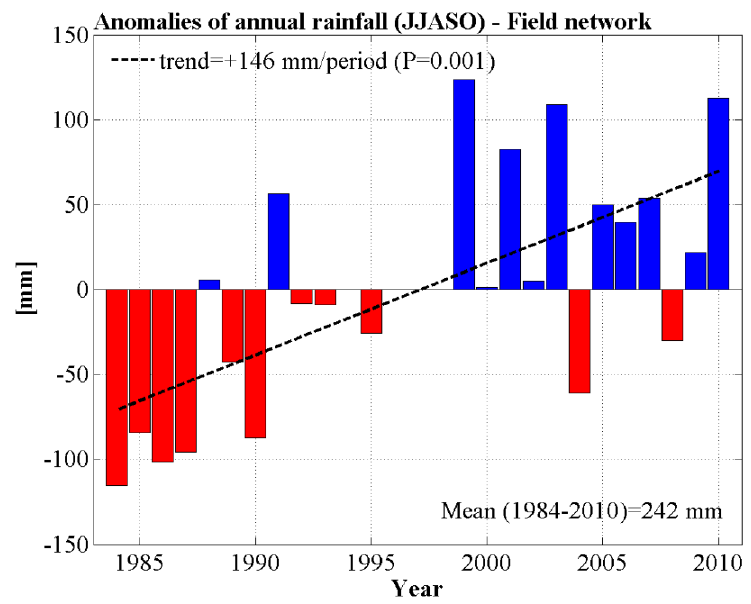
Figure 2. JJASO rainfall anomalies over 1984–2010 derived from averaging daily records from gauges installed near each vegetation site of the Gourma region. Anomalies are calculated from the 1984–2010 mean. They clearly show the recovery of the precipitation after the extreme drought of